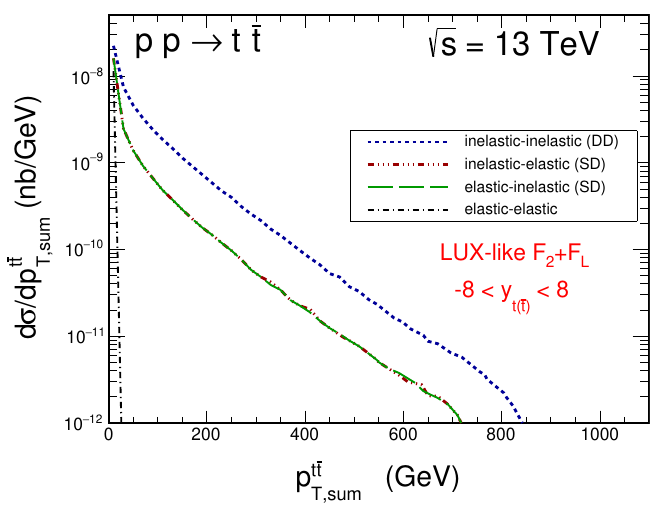
Figure 10 . Distribution in transverse momentum of the t and (cid:22) t pairs for elastic - elastic, inelastic- elastic (elastic-inelastic) and inelastic-inelastic contributions for LUX-like structure function. As the rapidity gap is potentially destroyed by a parton (jet or mini-jet), which is struck by the virtual photon out of the proton, we de(cid:12)ne a gap survival factor as simply the fraction of events with no jet in the veto region (cid:0) (cid:17)